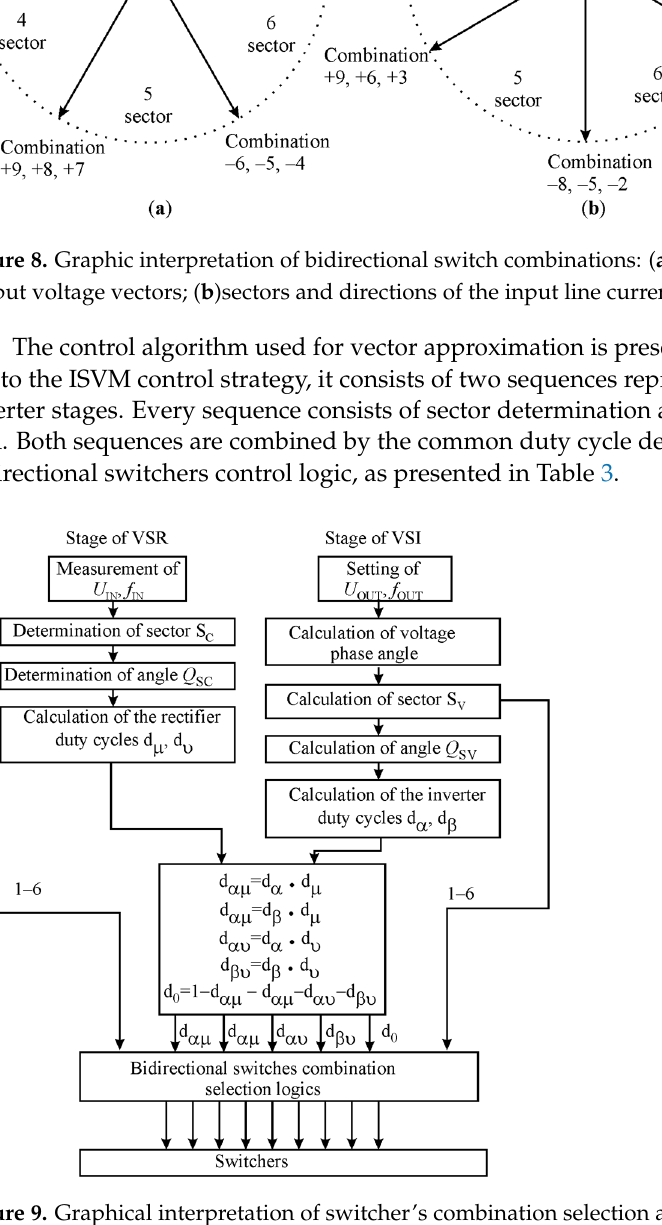
Figure 9. Graphical interpretation of switcher’s combination selection algorithm. Table 3. Bidirectional switches combination logic.